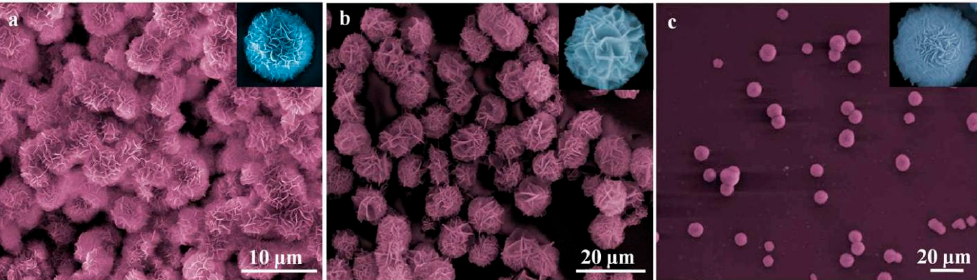
Figure 5. SEM images of ( a ) Co/BDC MOF fabricated with the solution concentration is 0.21 mol · L − 1 ; ( b ) Co/BDC ICP fabricated in the solution concentration is 0.104 mol · L − 1 ; ( c ) Co/BDC ICP sprayed in the reverse order. The inserts are the individual microparticles